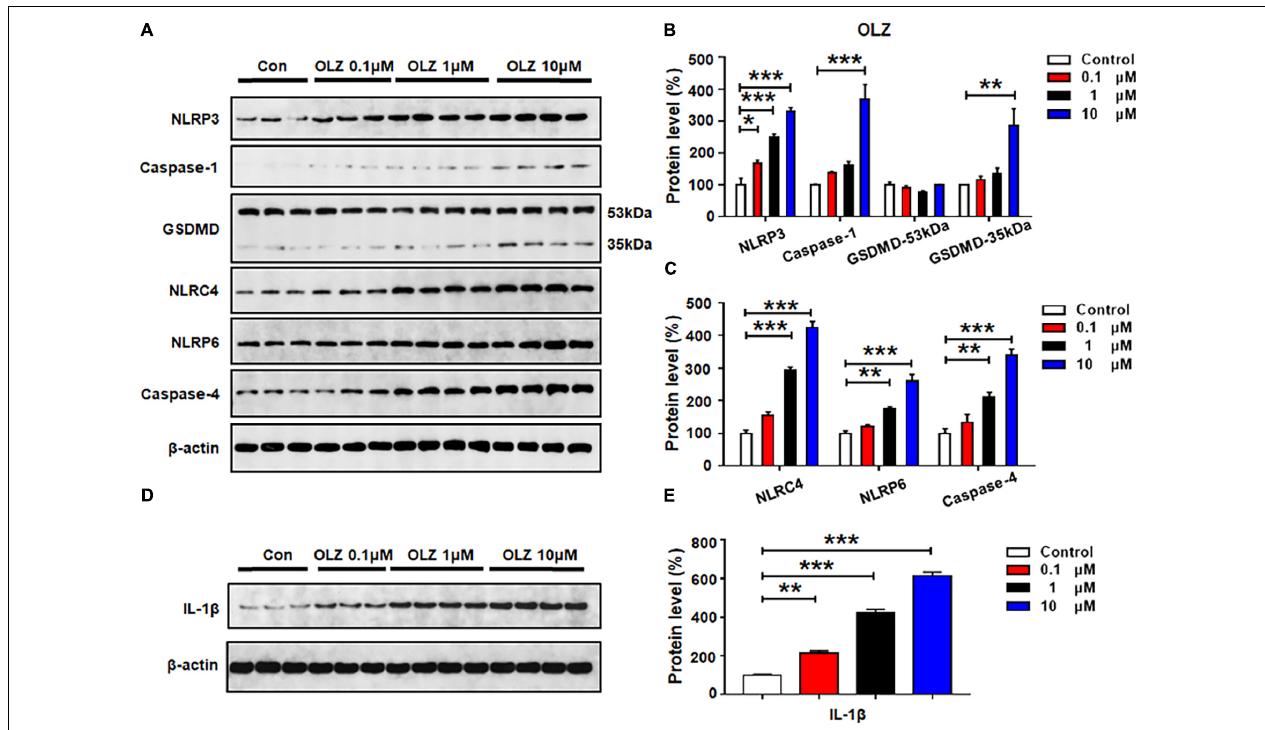
FIGURE 2 | Olanzapine treatment activated NLRP3/caspase-1 signaling, and increased NLRC4, NLRP6, and IL-1 β protein expression in cultured astrocytes. Cultured cells were treated with 0.1, 1, or 10 µ M olanzapine for 24 h. (A–E) Western blot was used to evaluate the expression of NLRP3, caspase-1 (20 kDa), GSDMD (53 and 35 kDa), NLRC4, NLRP6, and IL-1 β . The data are presented as the mean ± standard error of the mean. * p < 0.05, ** p < 0.01, *** p < 0.001 vs. control (one-way analysis of variance and post hoc Dunnett’s multiple comparison test; n = 3–4 cultures/western blot group). Con, control; OLZ, olanzapine.